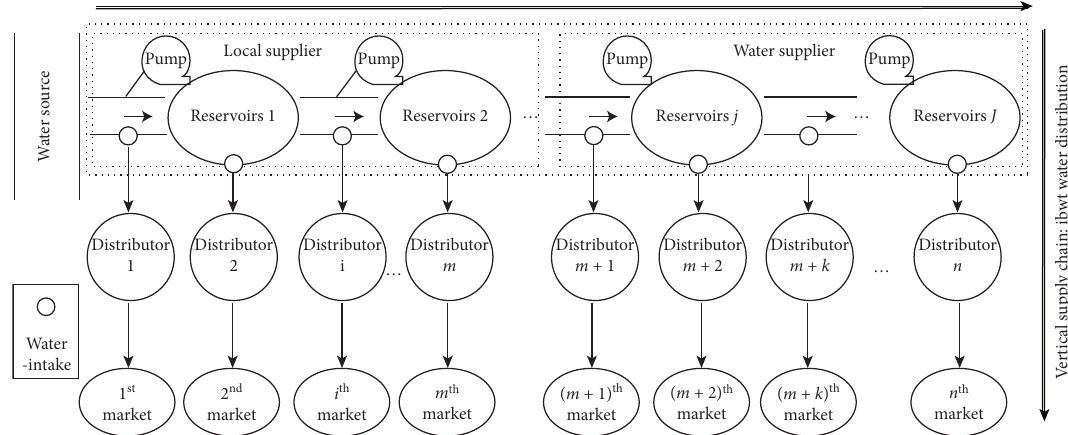
Figure 1: A generic interbasin water transfer supply chain